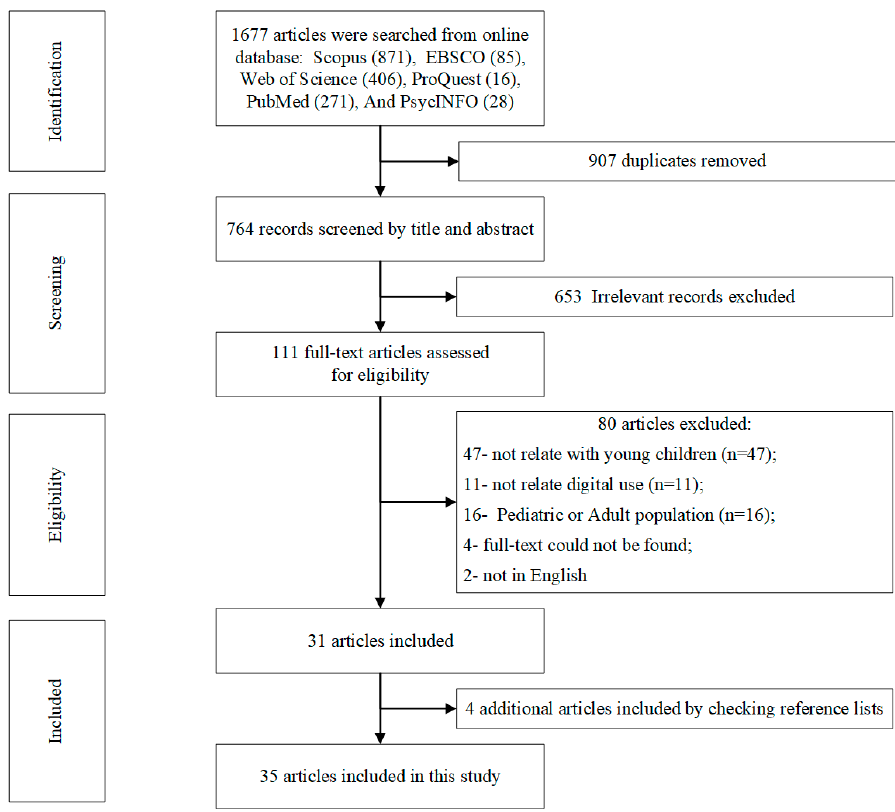
Figure 1. Flowchart of the literature selection process.